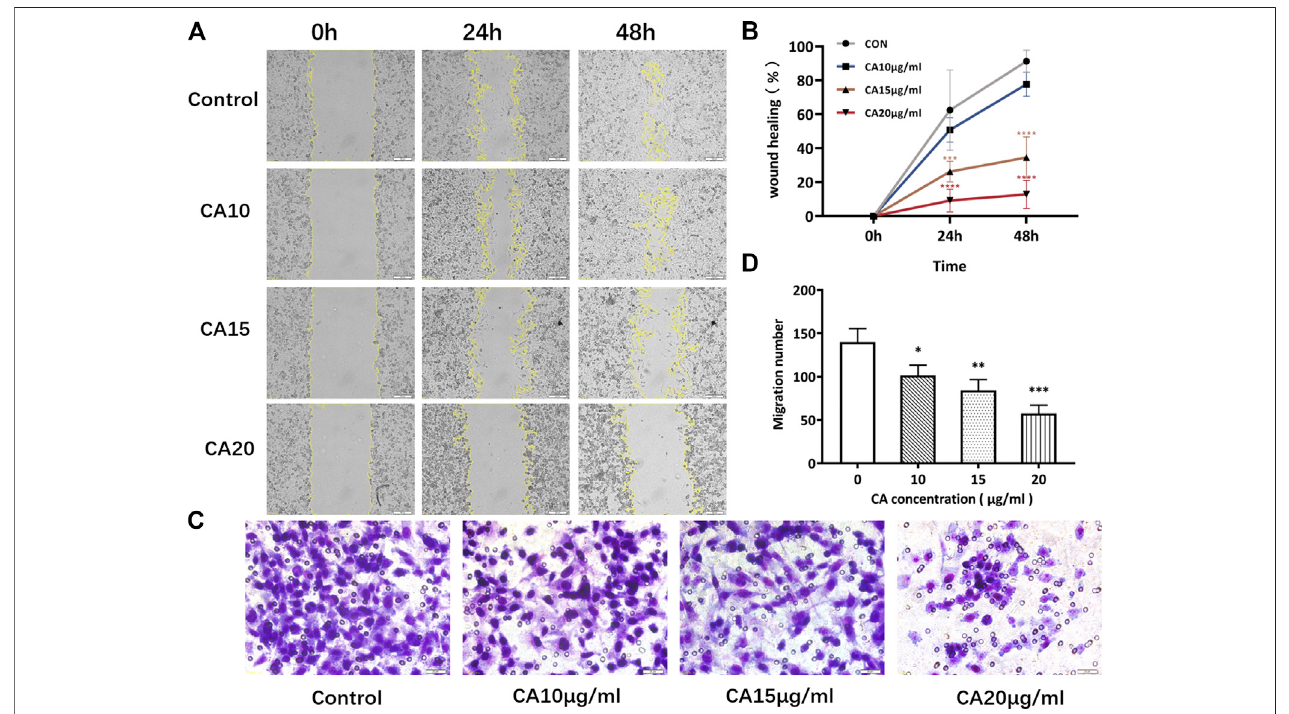
FIGURE 9 | Effects of different concentrations of cinnamaldehyde on the migration and invasion ability of MDA-MB-231 cells after a 48-h intervention. (A), (B) , Wound healing assay of MDA-MB-231 cells in different treatment groups (original magni fi cation, × 100). (C), (D) , Invasive assay after 48 h of CA intervention (original magni fi cation, × 200) ( p , pp , ppp , pppp compared to the control group p < 0.05, p < 0.01, p < 0.001, and p < 0.0001, respectively). CA, cinnamaldehyde.